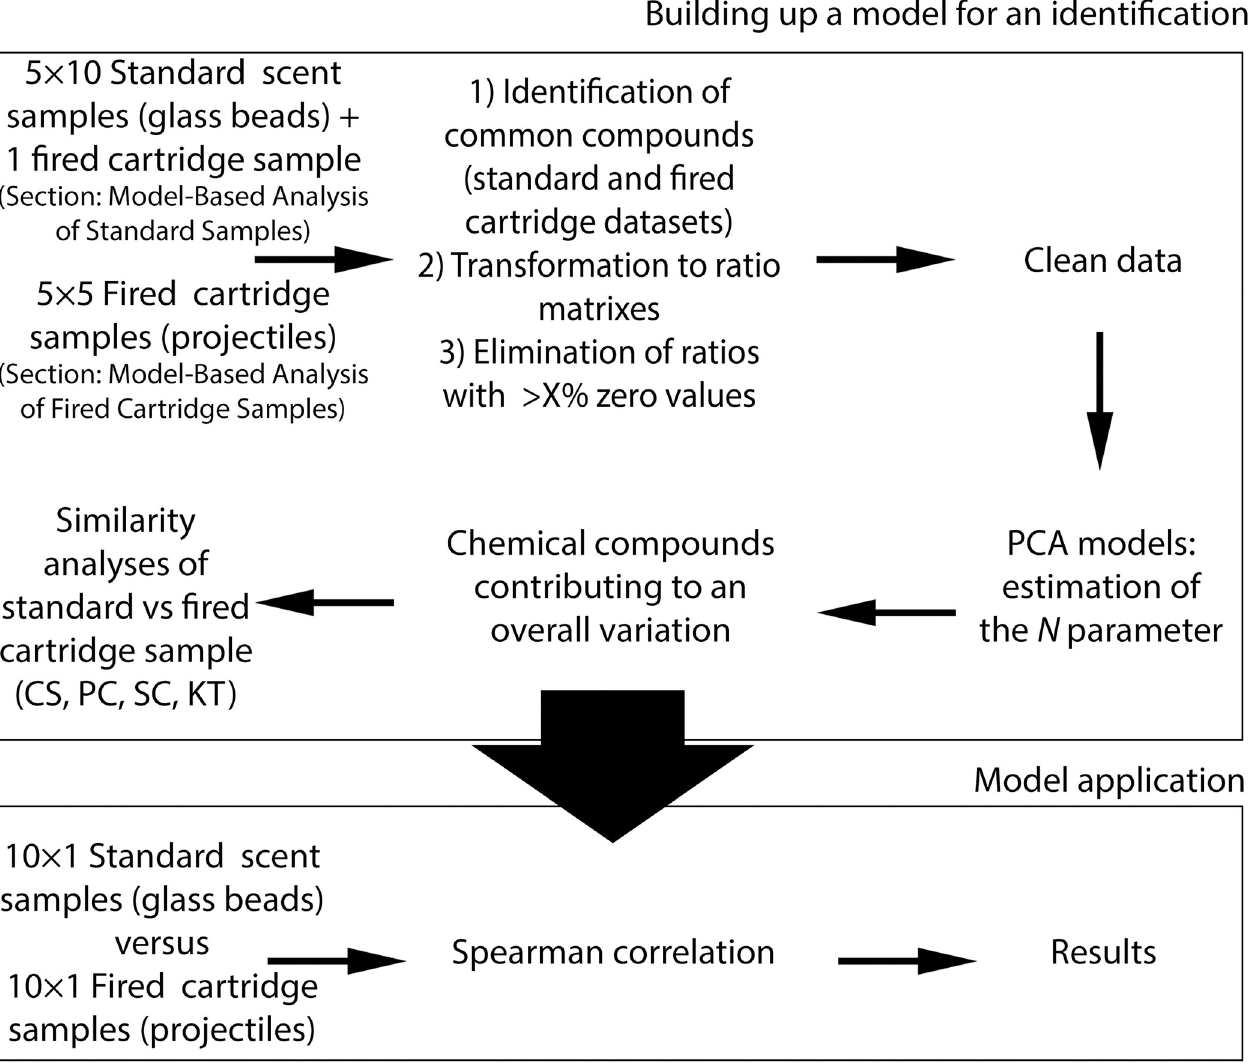
Fig 2. Scheme of an experimental process. For the model development (top box), two different datasets were used. Five volunteers sampled their scent on glass beads for ten times and additionally, they sampled their scent on a projectile once as well. Another five volunteers sampled their scent on the projectiles five times (in total, four samples were excluded from further calculations as they exhibited severe contamination). The rest of the top box describes general steps for the selection of the best performing models. The bottom box depicts the final application of the model on the data set of ten volunteers who gave one sample on glass beads and one sample on a projectile